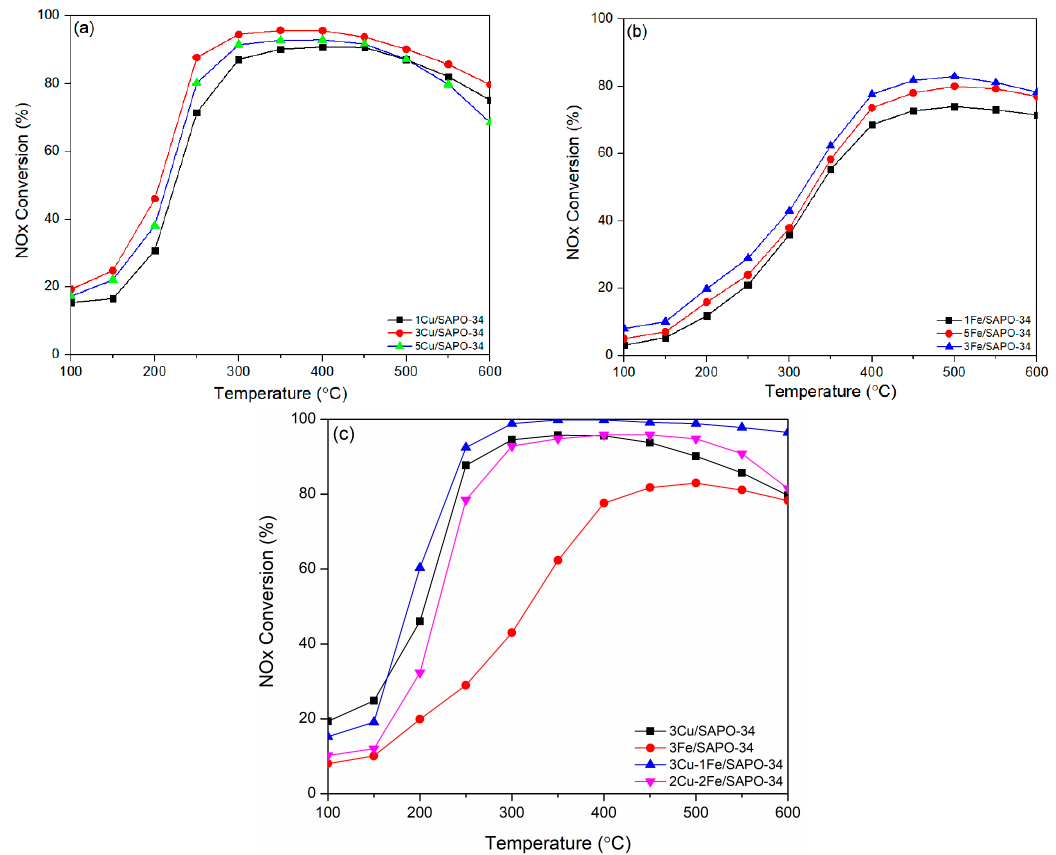
Figure 8. NO x conversion during standard NH 3 -SCR as a function temperature of the ( a ) Cu/SAPO-34, ( b ) Fe/SAPO-34, ( c ) Cu-Fe/SAPO-34 and comparison of all catalyst samples.